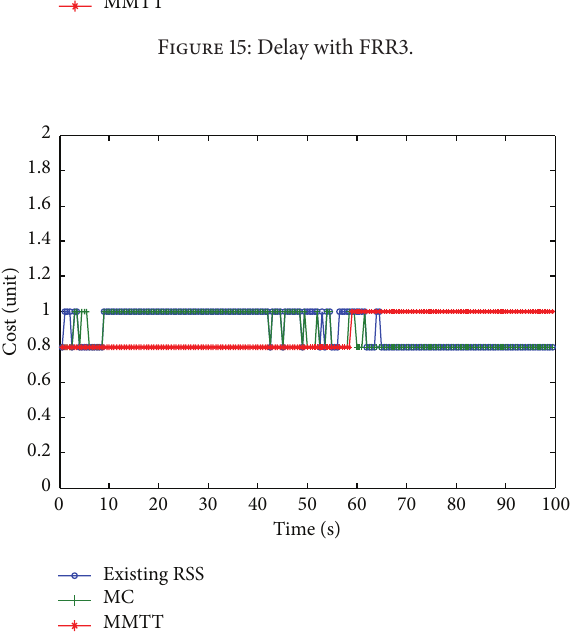
Figure 16: Connection